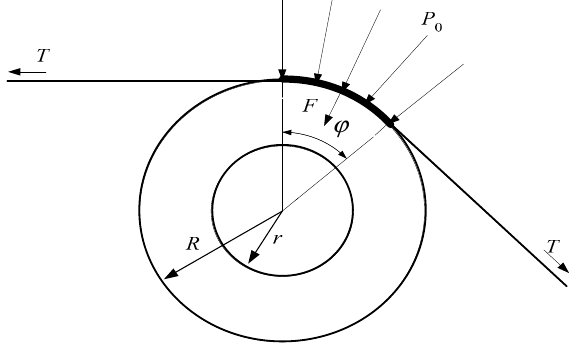
Figure 7. Forces acting on the roll of the entire roller-embedded shapemeter roll.